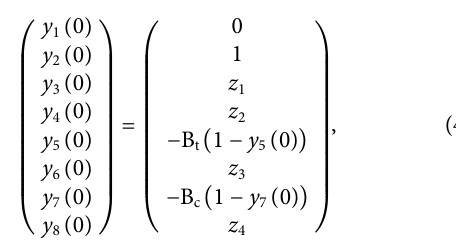
Frontiers in Physics |